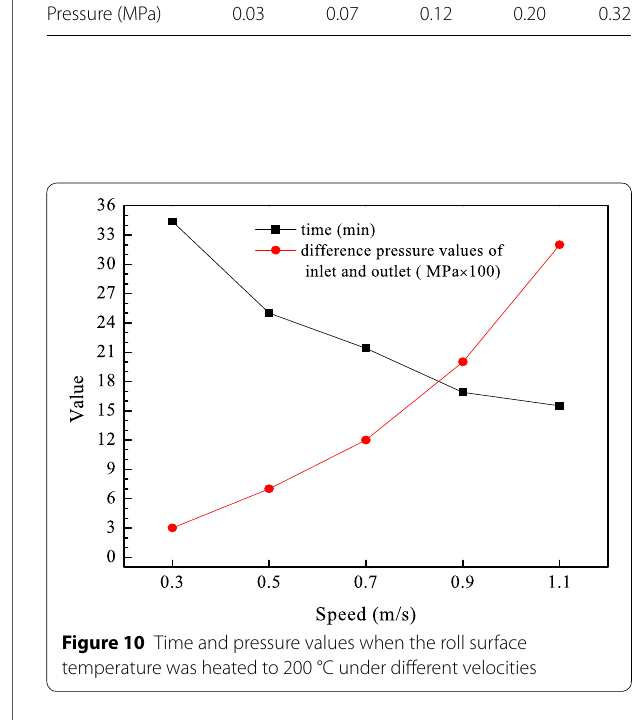
Figure 8 Temperature simulation value of the point a, b, c, and d, and the roll temperature field (after 10 min): v